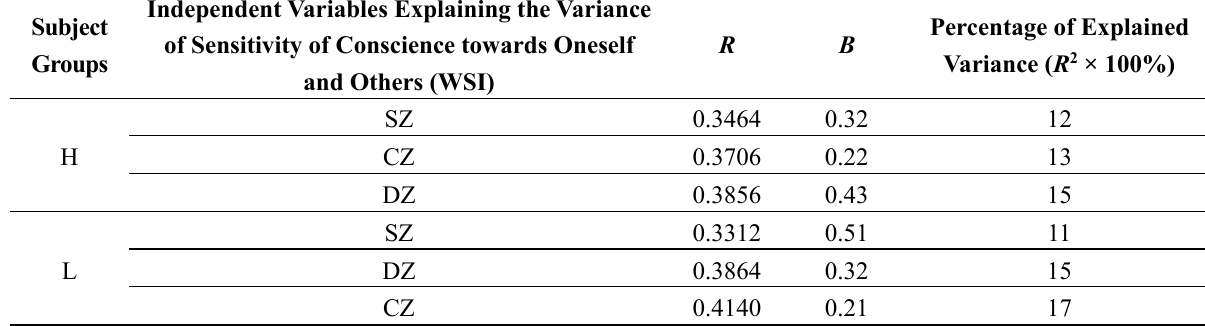
Table 2. Independent variables relating to meaning in life: a sense of meaning in life (SZ), attainment of goals (CZ), and affirmation of life (DZ), explaining variance in respect of sensitivity of conscience towards oneself and others (WSI) in groups of students with a high (H) and a low (L) level of experience of God’s absence. Results of multiple stepwise regression analysis.